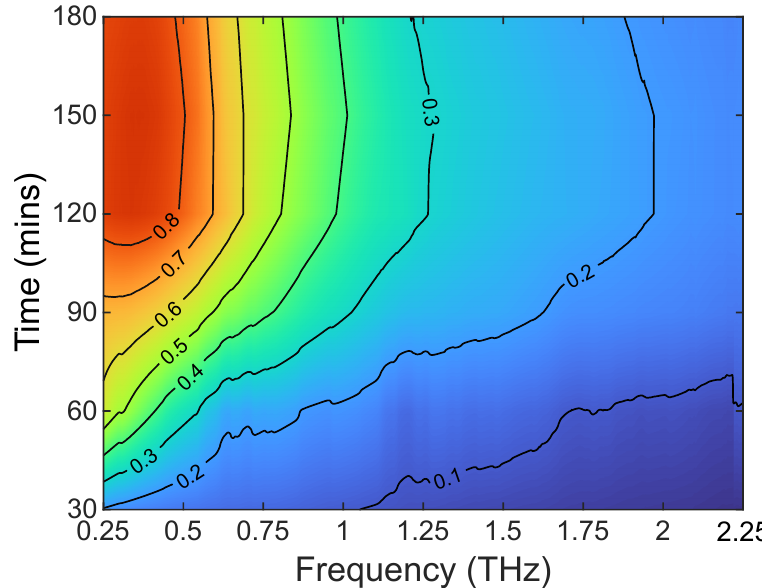
Figure 7. Time vs. frequency plot of calculated penetration depth for a Bambusa vulgaris leaf. Contours are penetration depth in